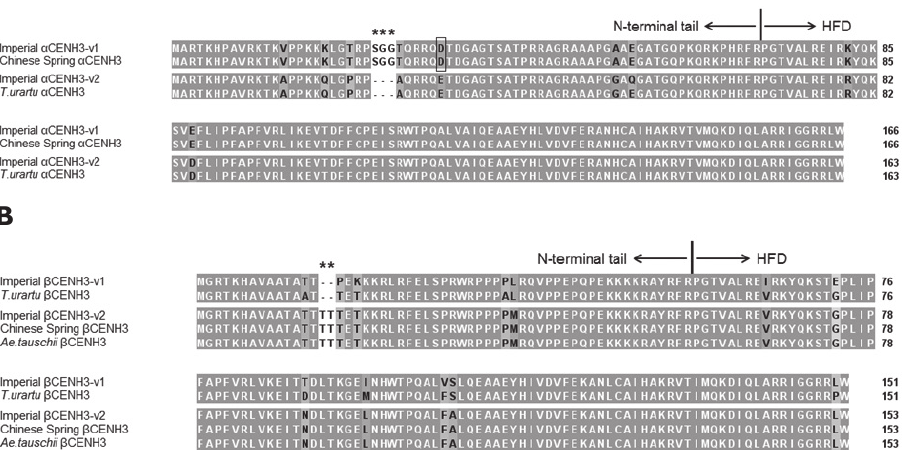
Figure 1. Examples of amino acid alignments of the different variants of the main forms of CENH3 in rye S. cereale (cv. Imperial) and Triticeae species: T. urartu (KM507181, KM507184) and Ae. tauschii (KM507186). A α CENH3 B β CENH3. Asterisks are above positions with short insertions/deletions in the N-terminal tail; the position with the highest percentage of amino acid substitutions is